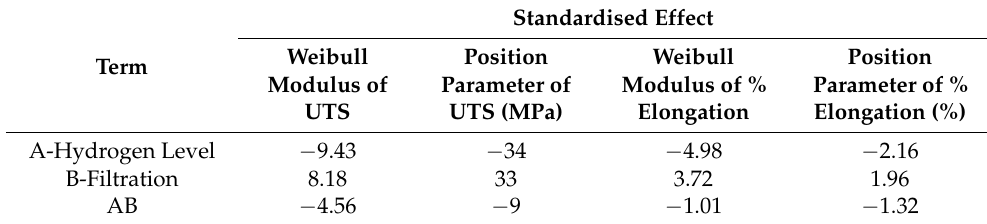
Table 3. Factorial analysis of the properties of the